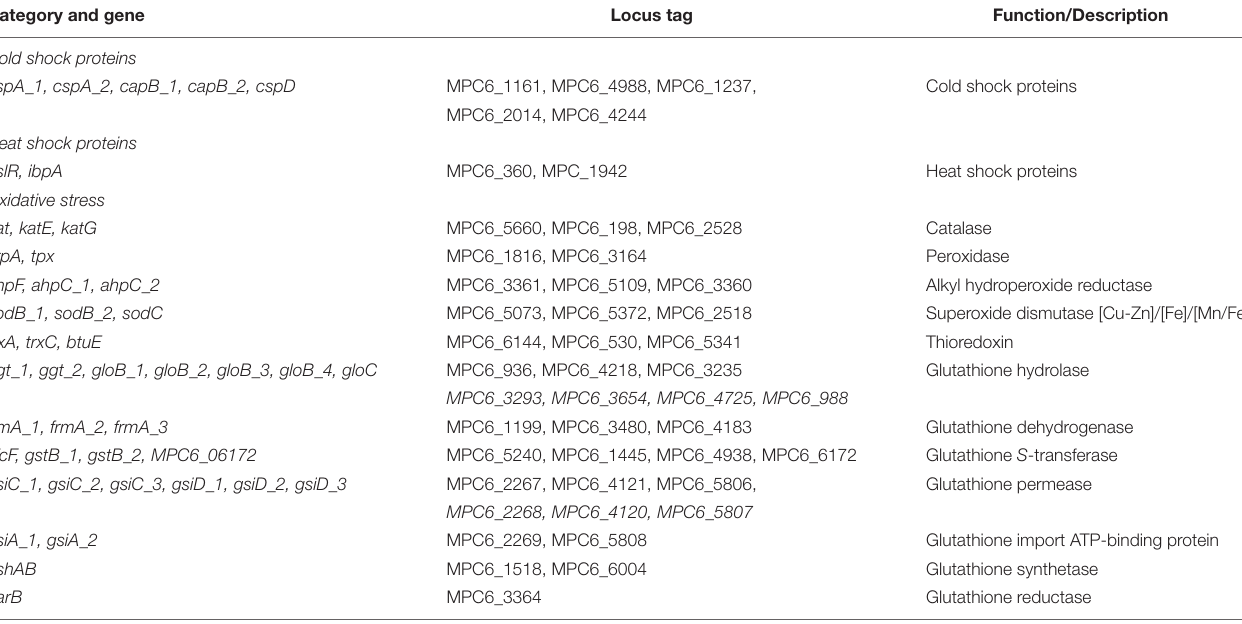
TABLE 2 | Genes involved in cold adaptation and oxidative stress found in Pseudomonas sp. MPC6. Category and gene Locus tag Function/Description